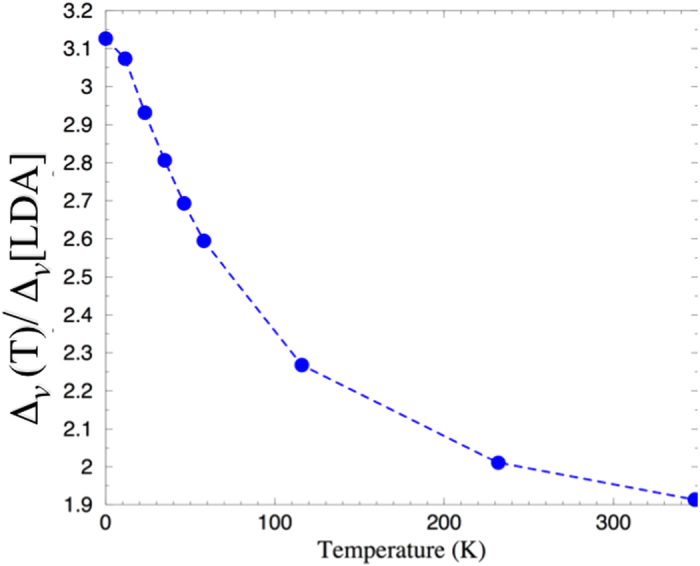
The temperature dependence of the hybridization gap (indirect), Δv(T)/Δv [LDA] = (Veff(T)/V)2 calculated in the Falicov-Kimball model Eqs (4) and (5).